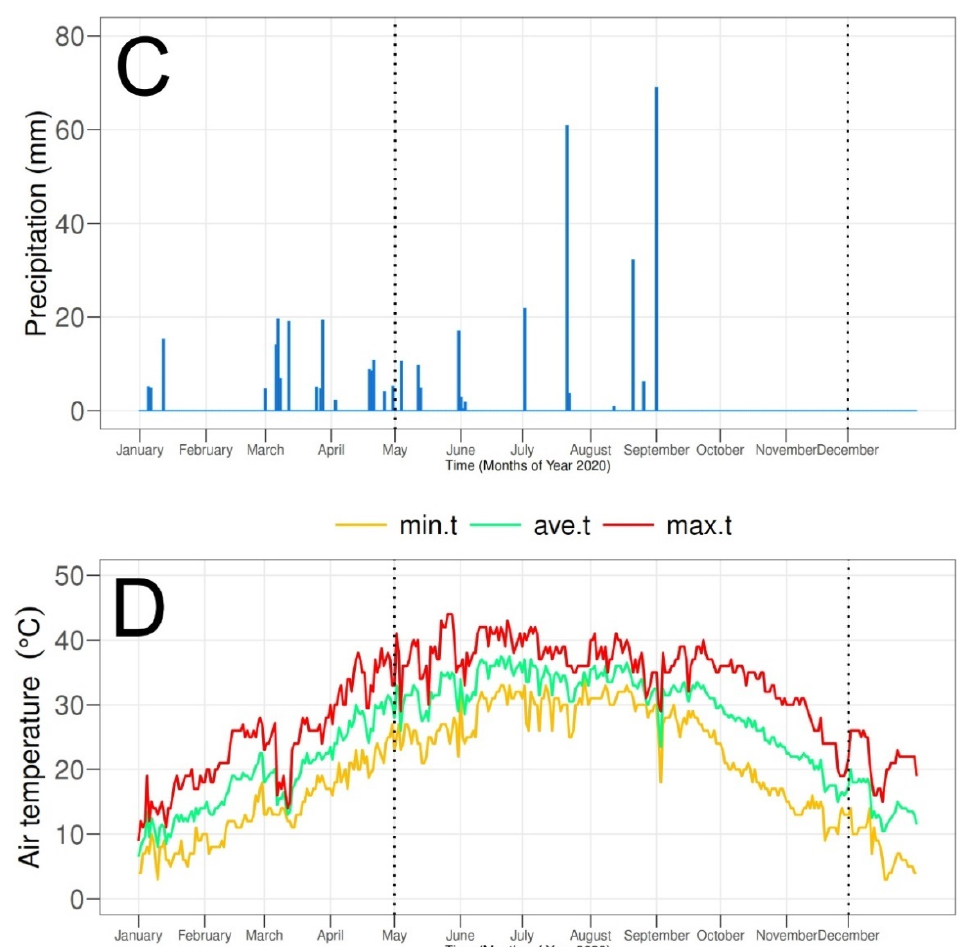
Figure 1. The daily minimum, maximum and average temperature and rainfall in Multan, Pakistan, during 2019 ( A , B ) and 2020 ( C , D ). The dotted lines show the duration of the mango crop.